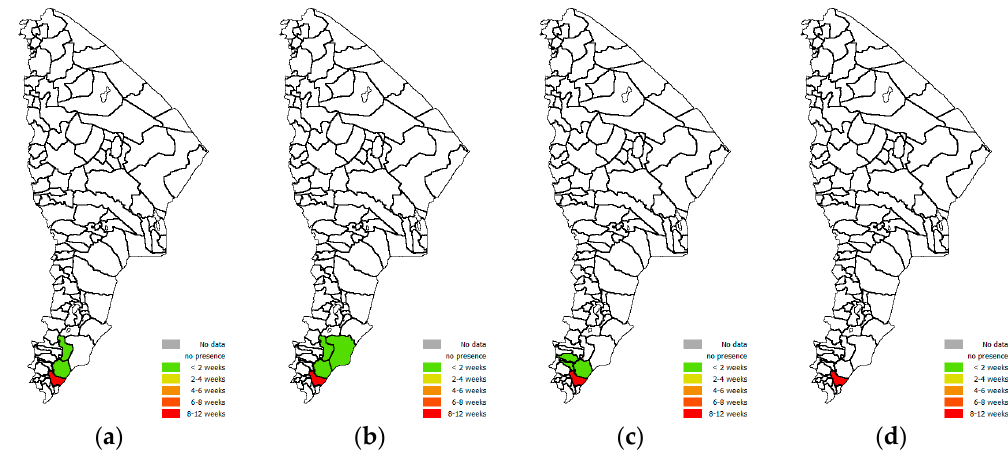
Figure 8. Harkamella sub-clan, Belig ( a ), Keremet ( b ), Bega ( c ) and Tsedaye ( d ) seasons (scale 1:9,900,000).